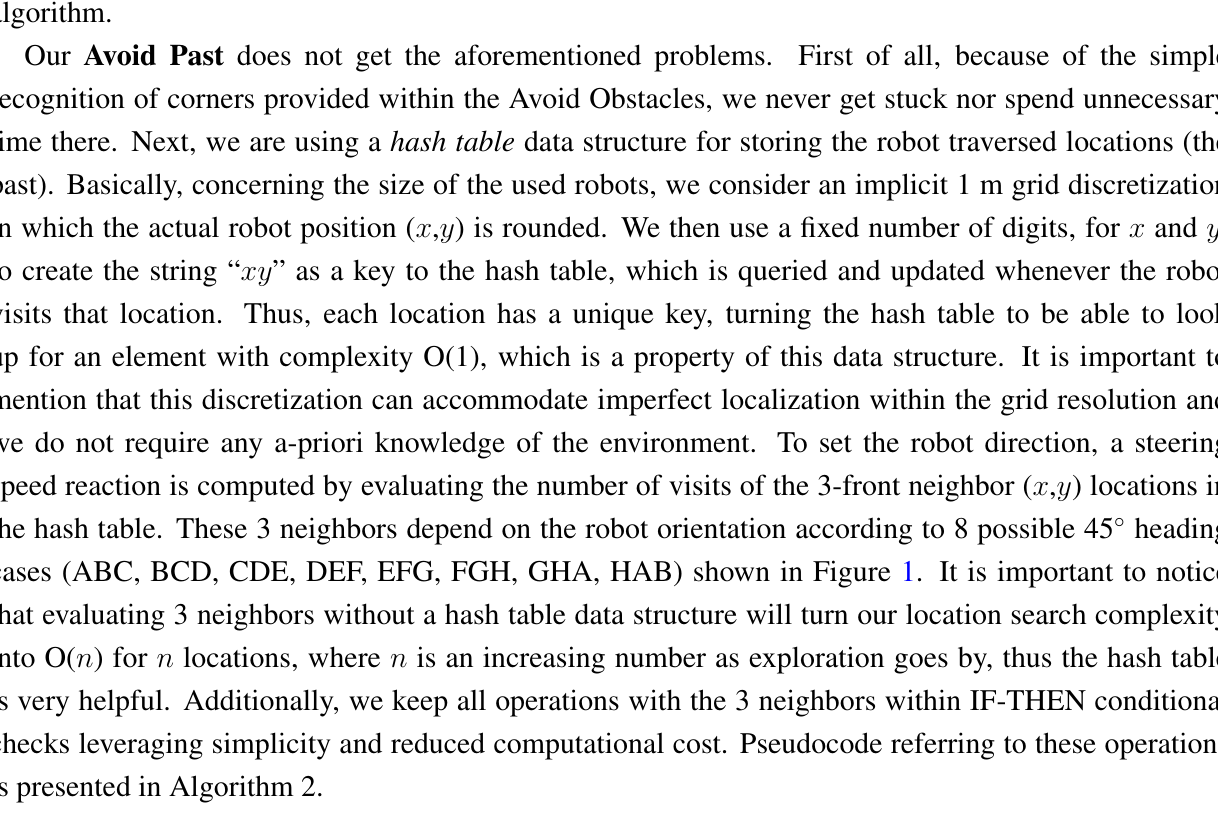
Figure 1. 8 possible 45 ◦ heading cases with 3 neighbor waypoints to evaluate so as to define a CCW, CW or ZERO angular acceleration command. For example, if heading in the − 45 ◦ case, the neighbors to evaluate are B, C and D, as left, center and right,